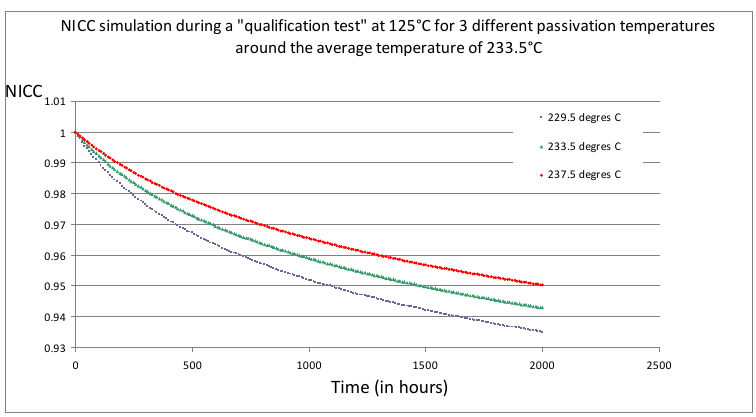
Figure 6. Simulation of accelerated ageing during 2000 h at 125 °C for a passivated grating during 10 min at different temperatures around 233.5